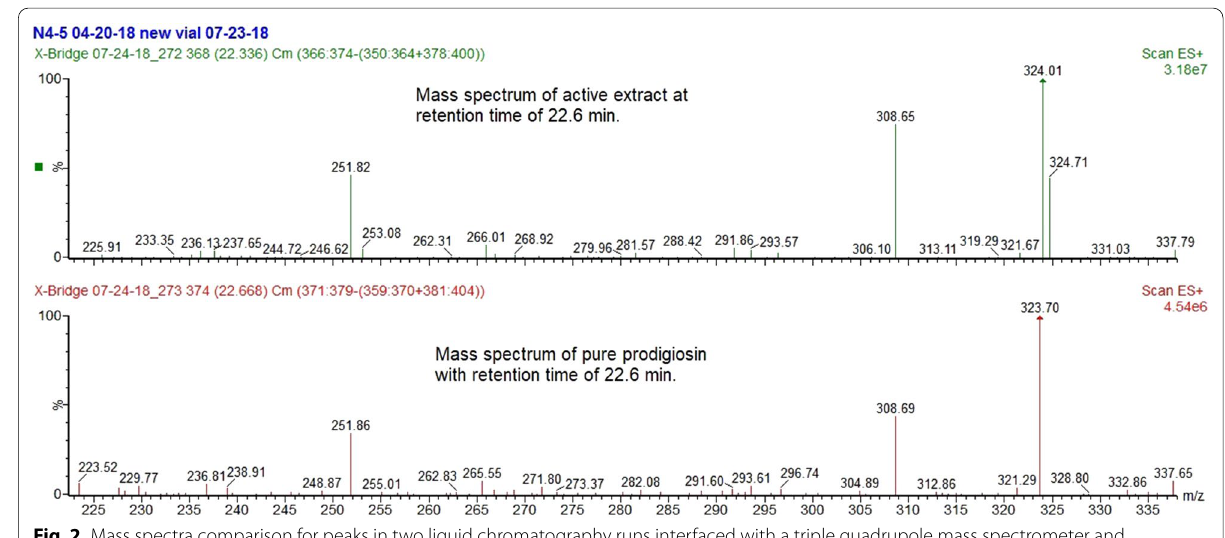
Fig. 2 Mass spectra comparison for peaks in two liquid chromatography runs interfaced with a triple quadrupole mass spectrometer and electrospray ionization source in positive ion mode of ethanol extract which eluted at 22.6 min. Top mass spectrometer spectra is for ethanol extract of Serratia marcescens N4-5 and lower mass spectrometer spectra is for the same retention time peak for the pure prodigiosin standard